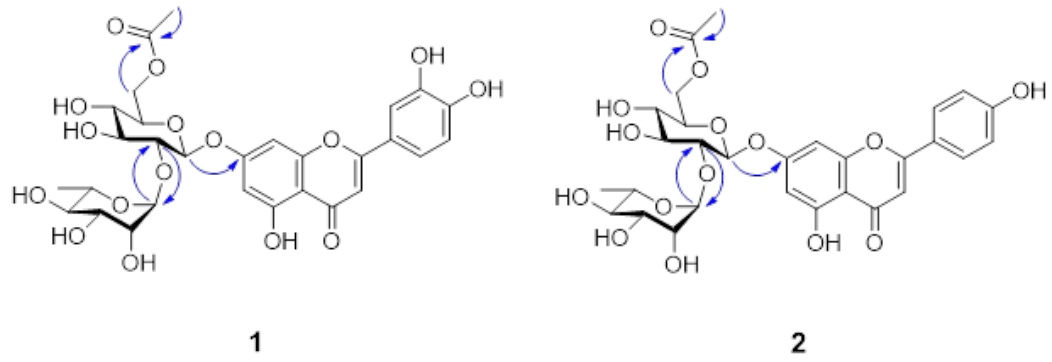
and it was designated as dorajiside I.